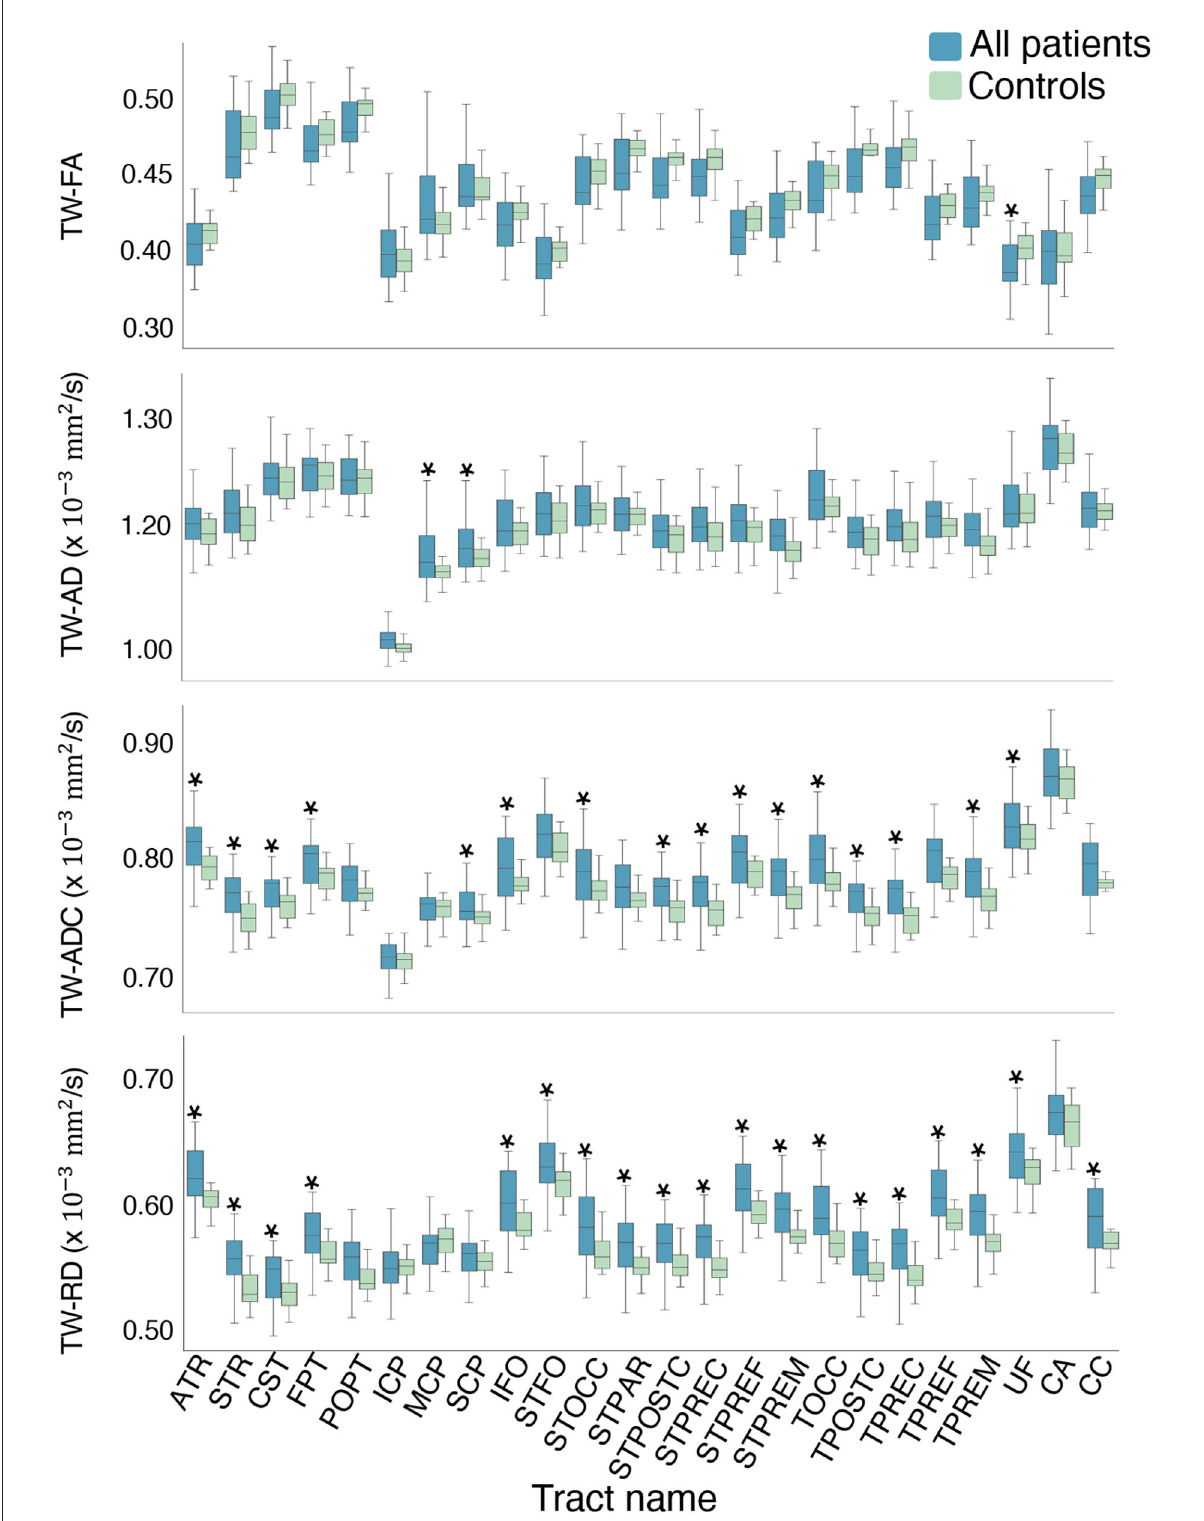
FIGURE3 Boxplots of the mean difference in TW-TM for each whole brain tract. The asterisks indicate the tracts where the mean TW-TM difference between the two groups was significant at p < 0.05. Notable results that support the hypothesis include the significantly higher